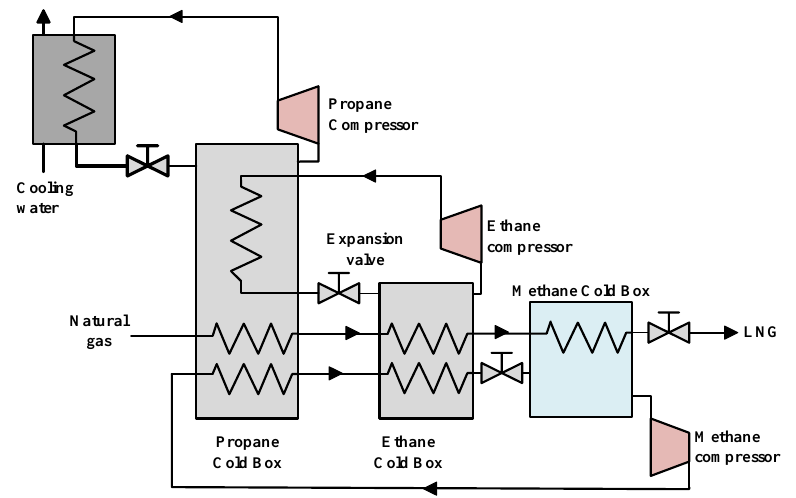
Figure 10. Schematic of cascade refrigeration cycle. Only one stage for each refrigerant cycle is shown for simplicity [100]. Reproduced with permission from [Elsevier], Elsevier, 2020.